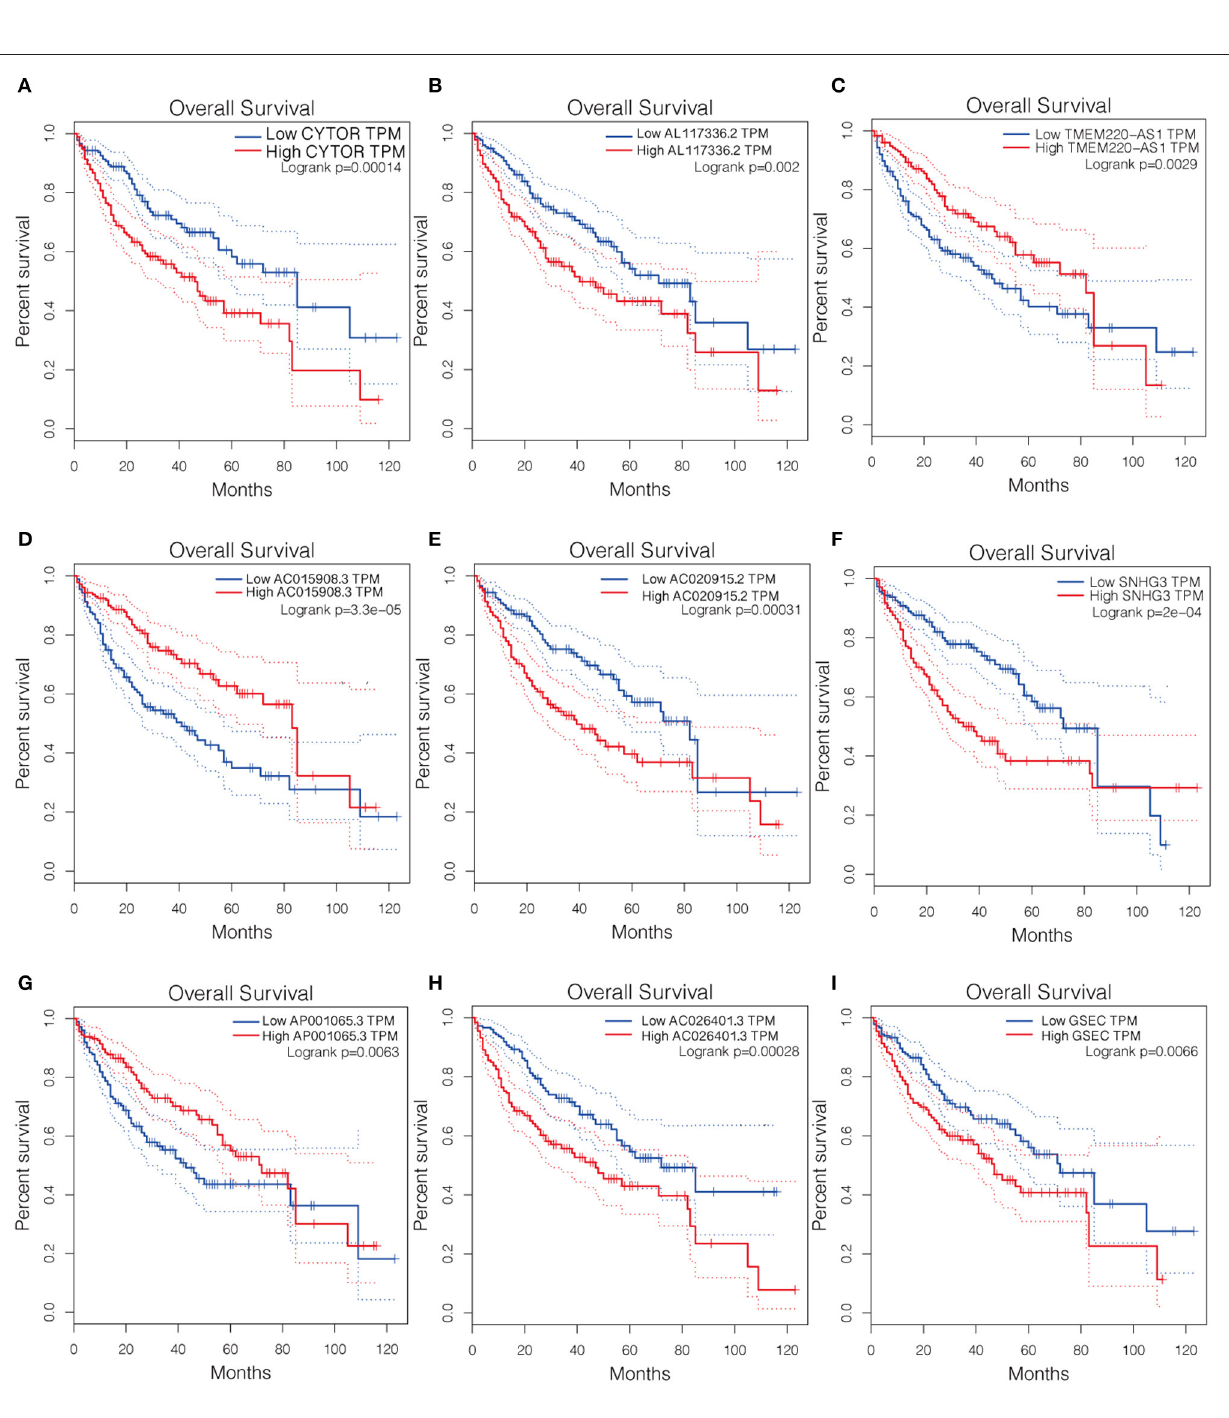
FIGURE 3 | Kaplan-Meier survival curves of the identified 9 pyroptosis-related lncRNAs in LICH-TCGA database using GEPIA. (A) CYTOR. (B) AL117336.2. (C) TMEM220-AS1. (D) AC015908.3. (E) AC020915.2. (F) SNHG3. (G) AP001065.3. (H) AC026401.3. (I) GSEC. LICH, Liver hepatocellular carcinoma; TCGA, The Cancer Genome Atlas; GEPIA, Gene Expression Profiling Interactive